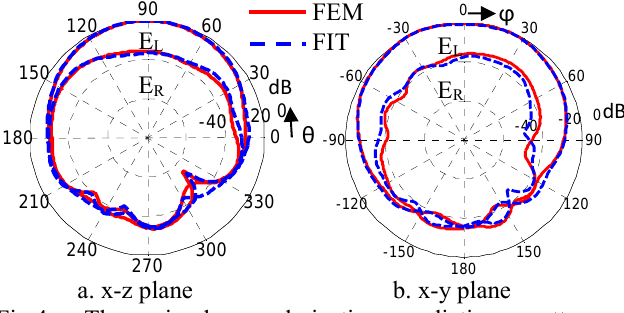
Fig.4. The circular polarization radiation pattern components of the circularly polarized DRA element mounted on a cylindrical ground plane in free space, at f=5.8 GHz.